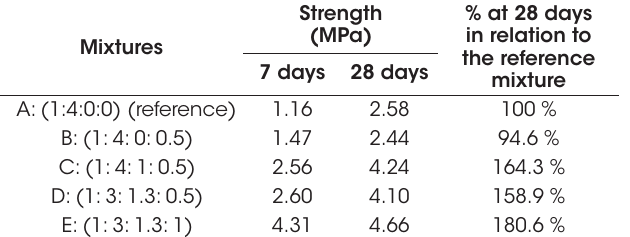
Axial compression strength